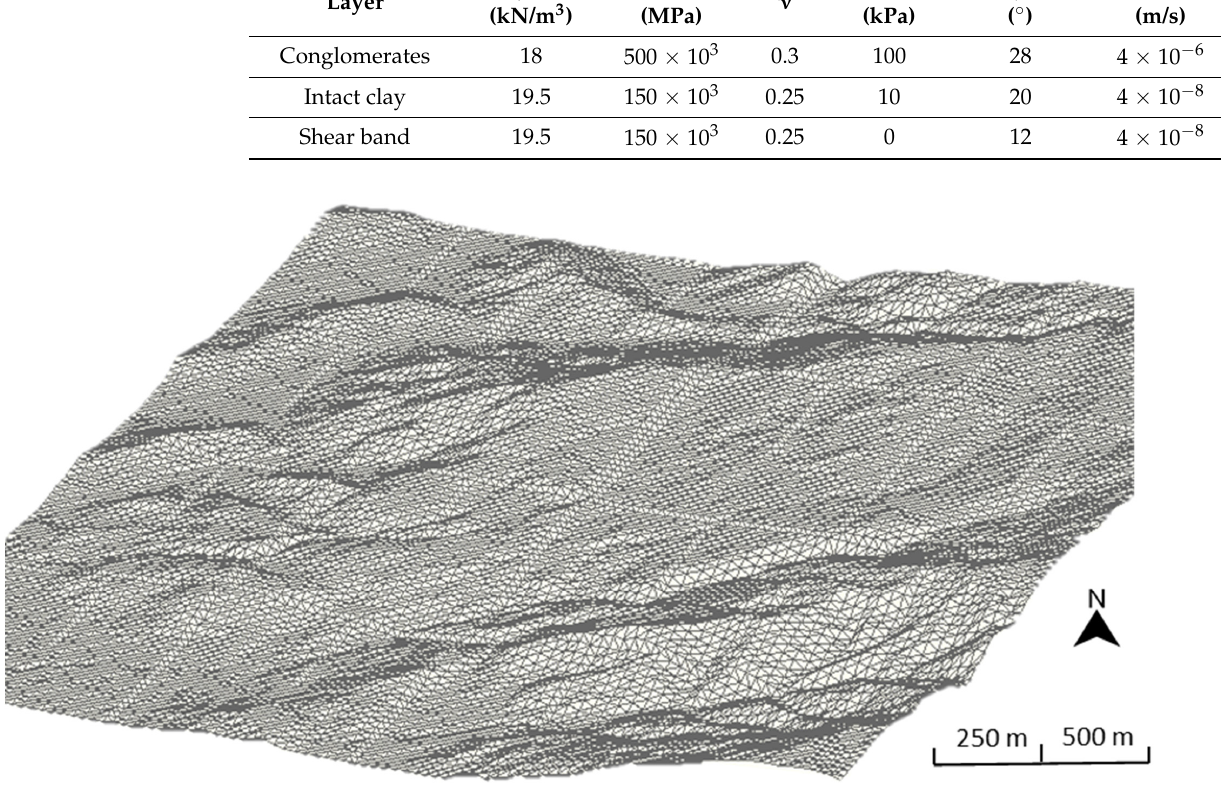
Figure 9. DEM adopted for the construction of the 3D FEM model. Table 2. Soil hydraulic and mechanical parameters adopted in the stress–strain FEM analyses. γ sat E ′ Layer (kN/m 3 )